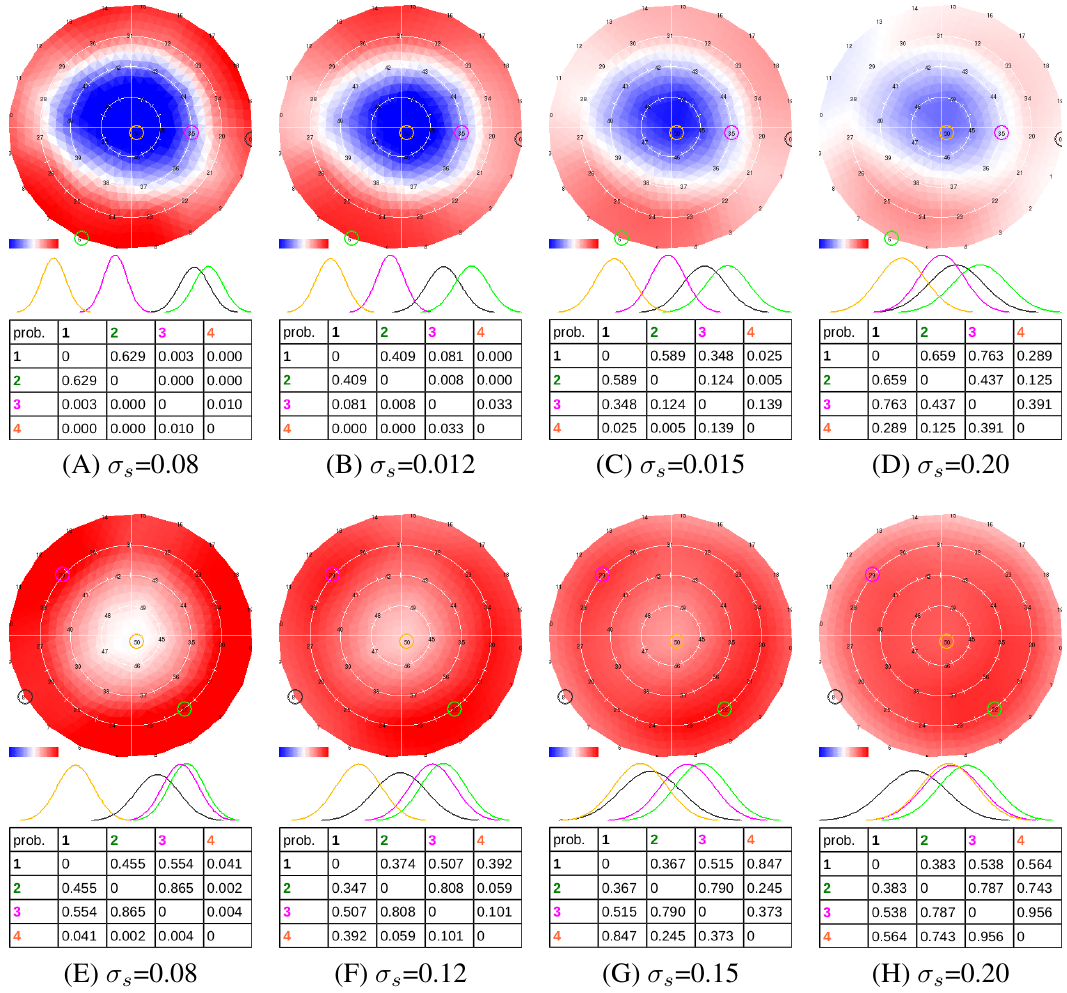
Figure 4. Tomograms, posterior probability density functions and associated amounts of overlap for selected nodes in the tomograms. Selected node markers and associated curves are marked in the same colour in each case. Both a ring structure: (A–D) and a homogeneous case (E–H) are displayed.